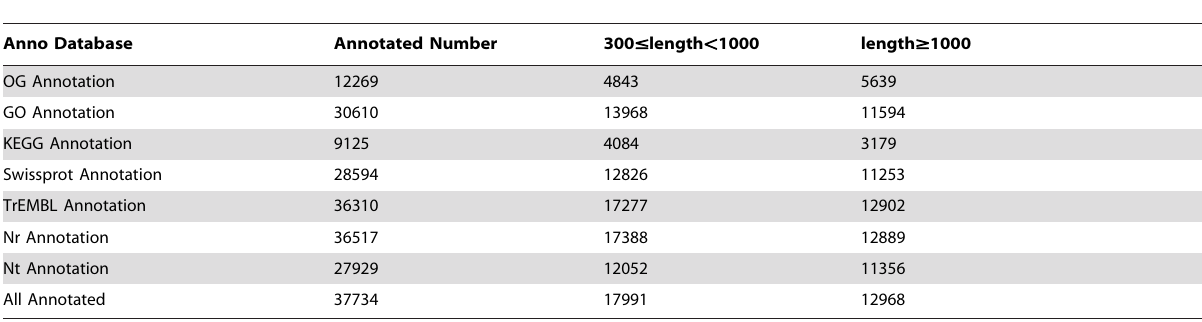
Table 2. Functional annotation of the Youngiajaponica transcriptome.